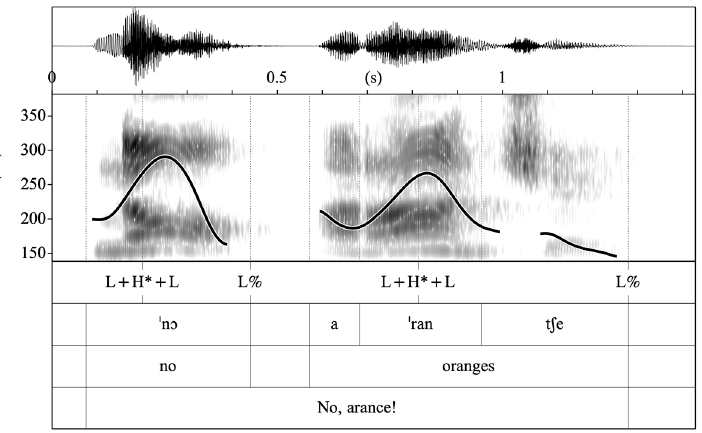
Figure 4. Waveform, spectrogram and F0 trace of the contrastive focus statement No, oranges! in L1 Italian produced with L+H*+L L%.